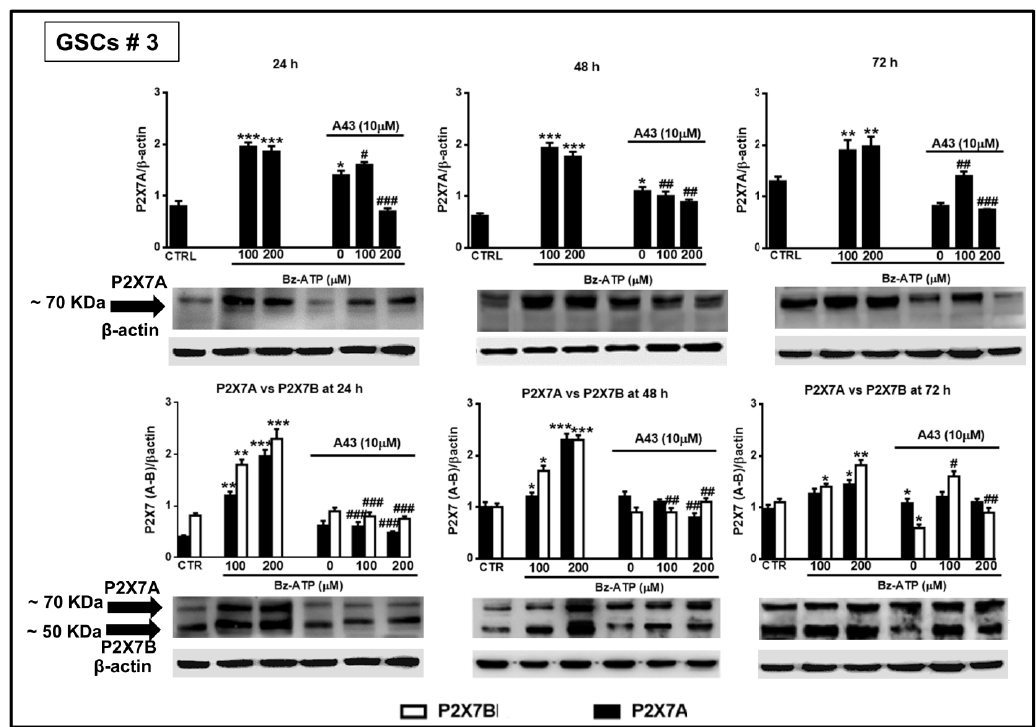
Figure 14. Modulation of the protein levels related to the P2X7R splice variants A and B in GSCs #3 exposed to BzATP. GSCs #3, cultured up to their confluence in vitro, were harvested at different time points following their exposure to BzATP and/or A438079. Protein levels of P2X7A and P2X7B splice variants were determined by western blot analysis as reported in the legend of the Figure 13. Immunoblots were re-probed with an antibody against β actin, quantified by densitometric analysis, normalized to β actin used as an internal control, and reported in the histograms. Densitometric values are the mean ± SEM of three independent experiments with very similar results. * p < 0.05, ** p < 0.01, *** p < 0.001: statistical significance vs. untreated cells (CTR); # p < 0.05, ## p < 0.01, ### p < 0.001: